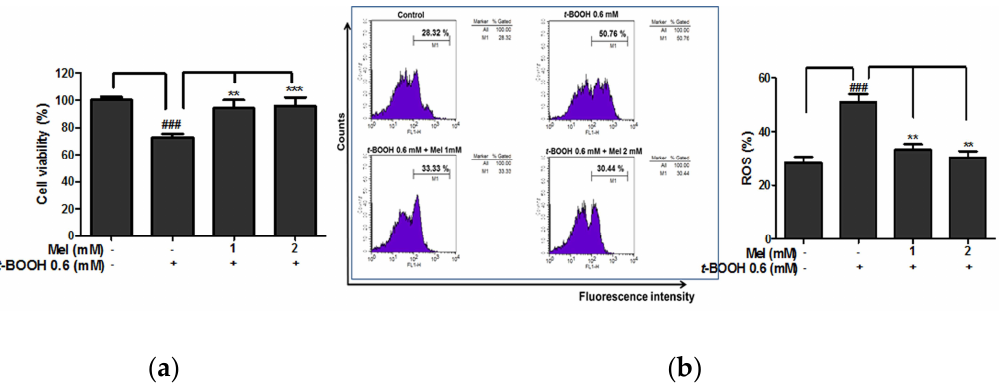
Figure 2. Melatonin suppressed t-BOOH induced cytotoxicity and ROS production in HaCaT keratinocytes. ( a ) Cells were pretreated with melatonin for 24 h and then with t-BOOH (0.6 mM) for 6 h. ( b ) ROS generation (%) was measured using ROS-sensitive fluorometric probe 2,7-dichlorofluorescein diacetate (DCFDA) by flow cytometric analysis. Data represent means ± SD. *** p < 0.001 and ** p < 0.01 versus t-BOOH control, ### p < 0.001 versus normal